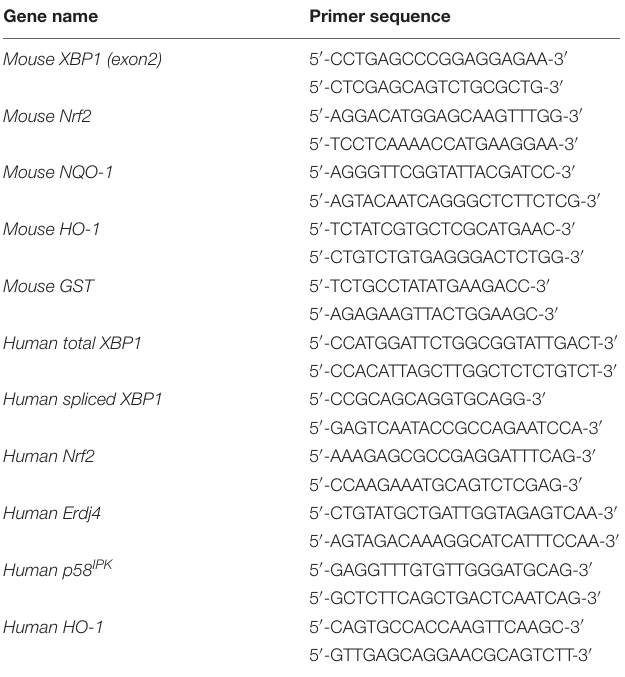
TABLE 1 | Primers used for quantitative real-time